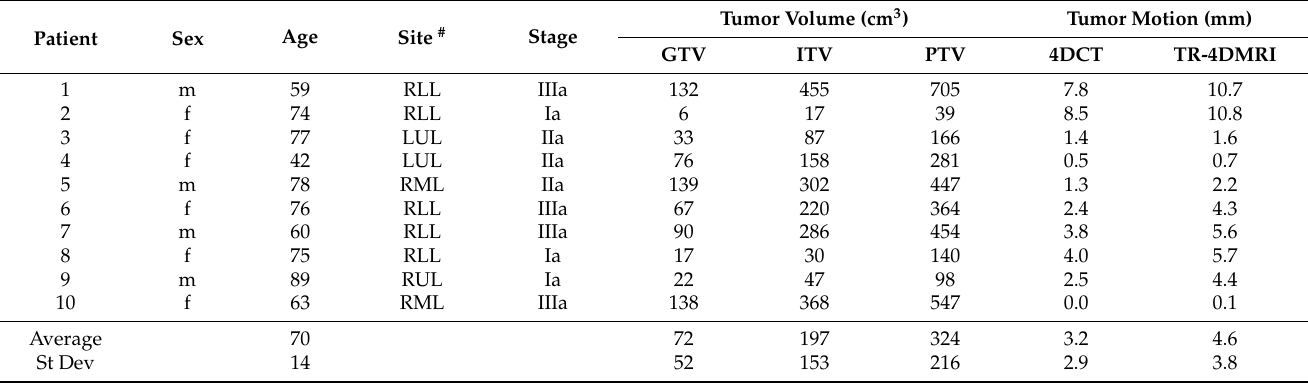
Table 1. Tumor locations, volumes, stages, and native tumor motion amplitudes in 4DCT and TR- 4DMRI. Patients 2, 8, and 9 received hypo-fractional stereotactic body radiotherapy (SBRT with